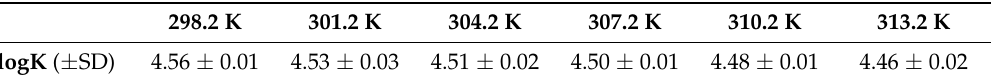
Table 1. Binding constants of TIL-BSA complexes at different